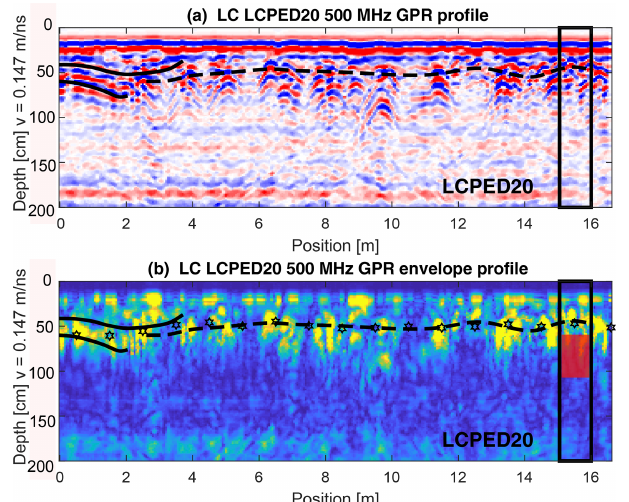
Figure 13. 1000MHz GPR signal and envelope for the mid-slope position of the S-facing hillslope position in Santa Gracia (SG- PED40). The hillslope transect spans over ∼ 20m. Interpretation of the radar signal is indicated where possible (stippled lines in a and b ). The potential pedolith thickness is indicated based on the envelope profile. Uphill is from left to right. Lines and symbols in figures as described in Fig. 12.